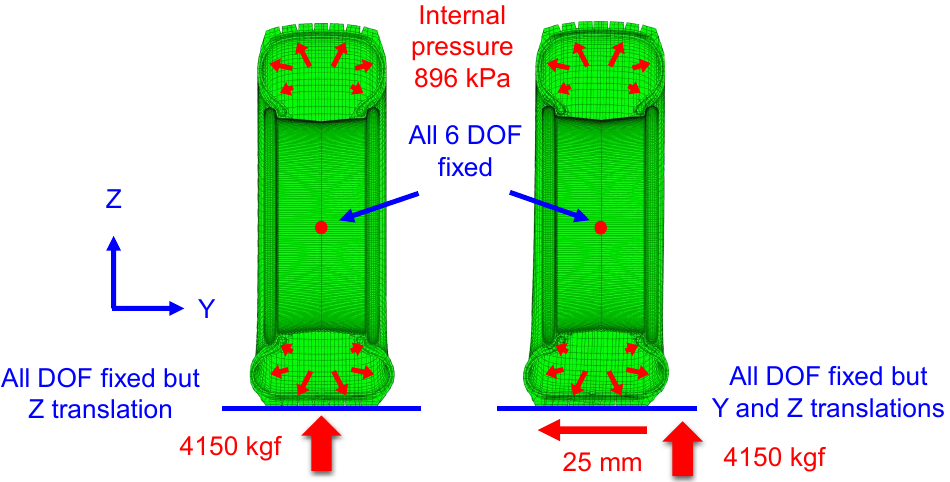
Figure 2. Boundary conditions for calculations of vertical and lateral stiffness of the tire model.